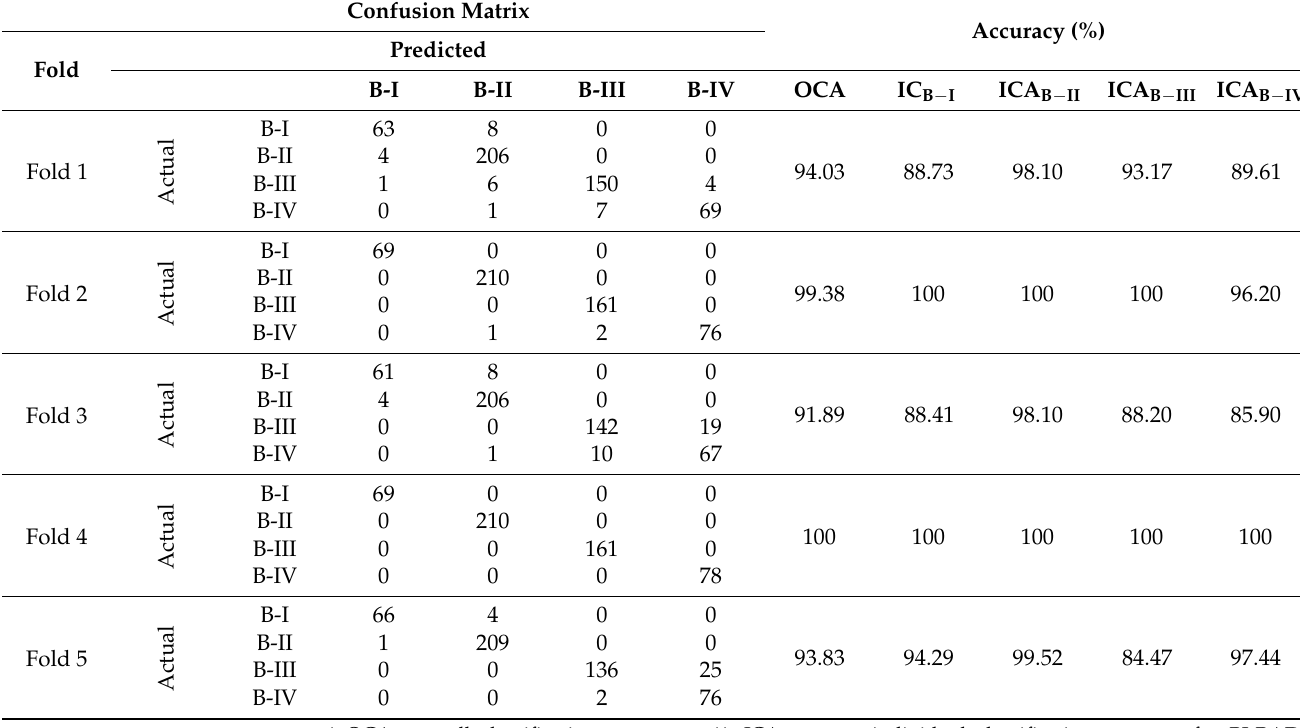
Table 7. Confusion matrix of 5-folds of the best test (* OCA) and (**